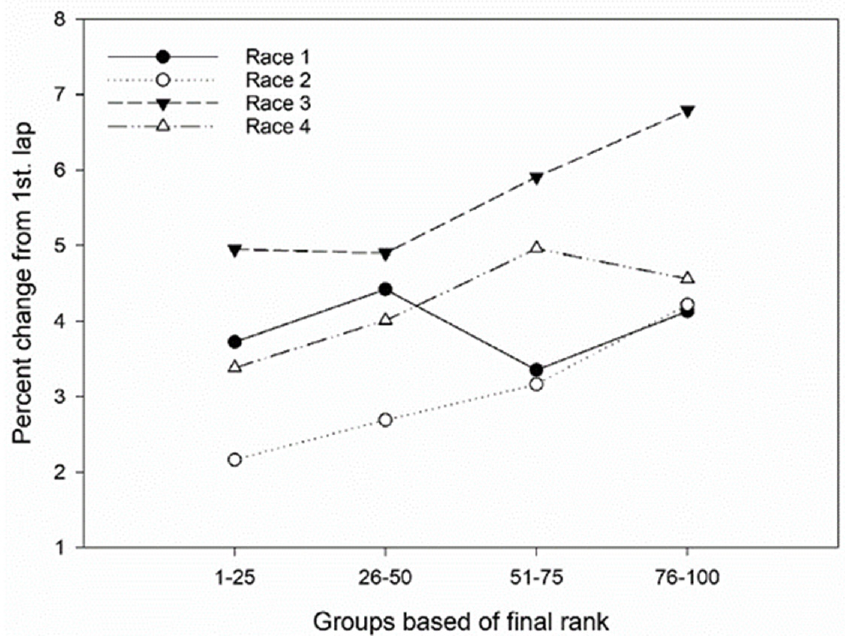
6 of 11 Figure 1. The individual speed changes between 1st versus 2nd and 3rd laps for the 100 best in the